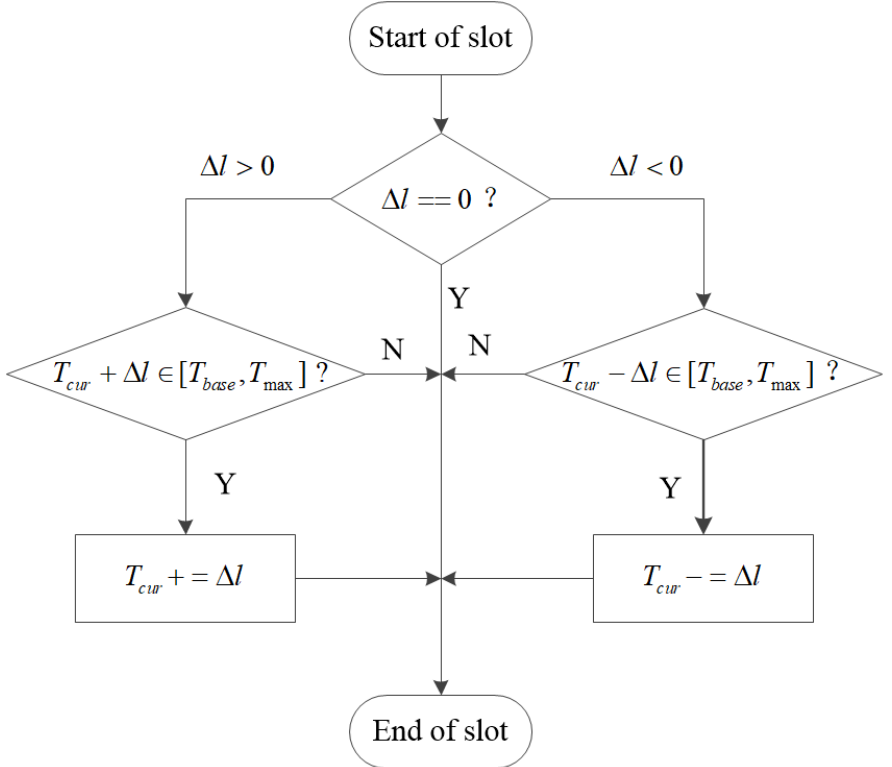
Figure 8. Flow chart of adaptive packet length algorithm.